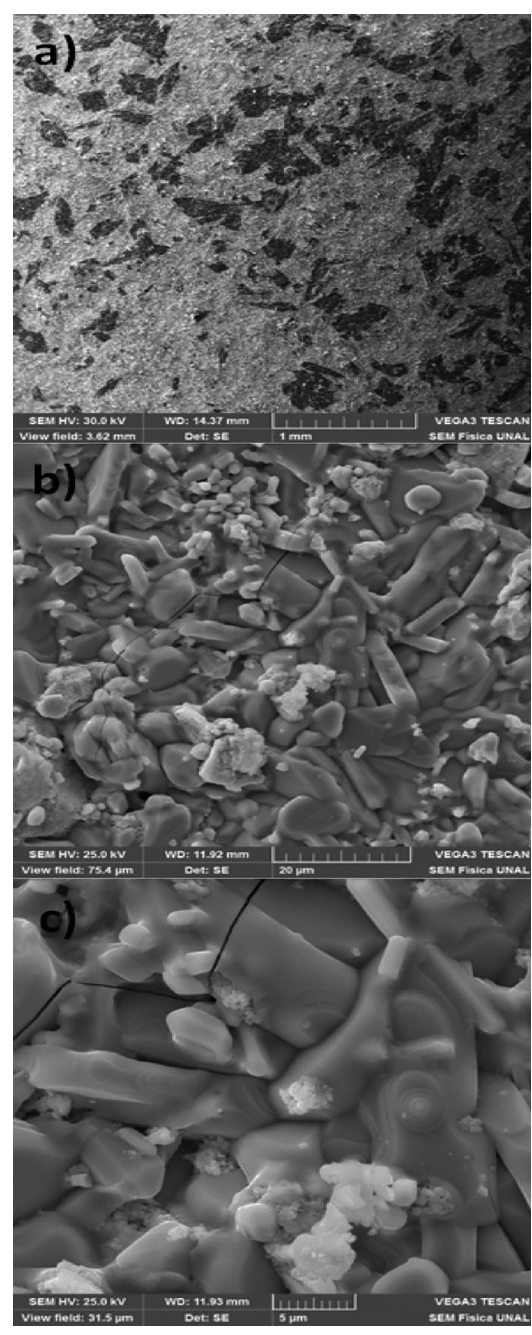
Figure 6: Scanning electron microscopy for (a) 30 mass% YBCO, 70 mass% SHNO, (b) and (c) 90 mass% YBCO, 10 mass% SHNO in SHNO-YBCO